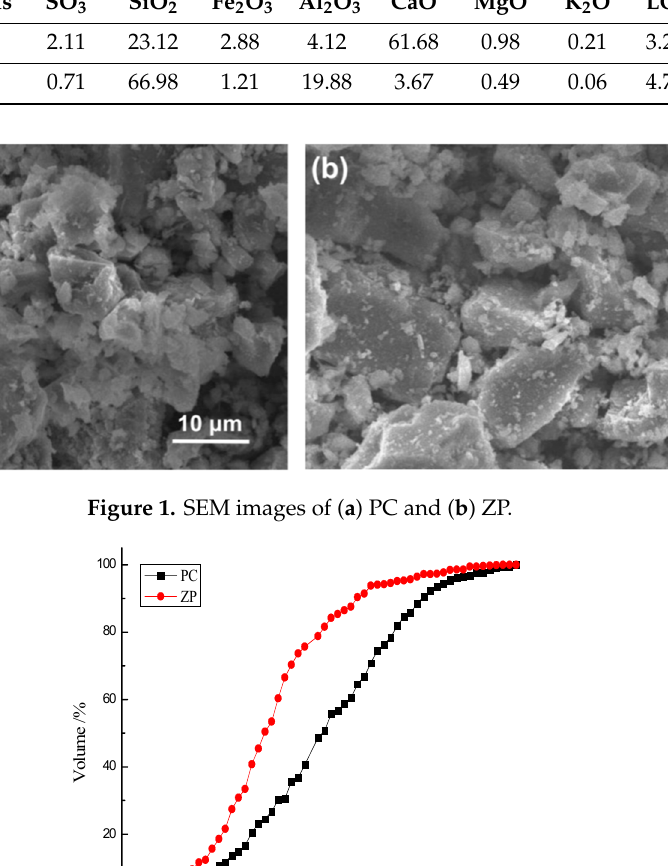
Table 2. Mix proportions of concretes (kg/m 3 ).